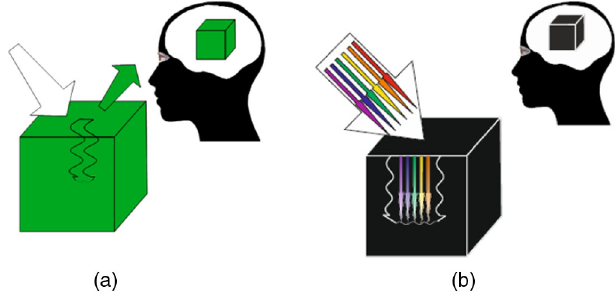
FIG. 10. (a) Pictorial representation of selective absorption and selective reemission. Body color conceptualized based on the SESR mechanism. (b) Pictorial representation of selective ab- sorption and selective reemission with “ black objects. ” FIG. 11. Experiment for distinguishing yellow and white